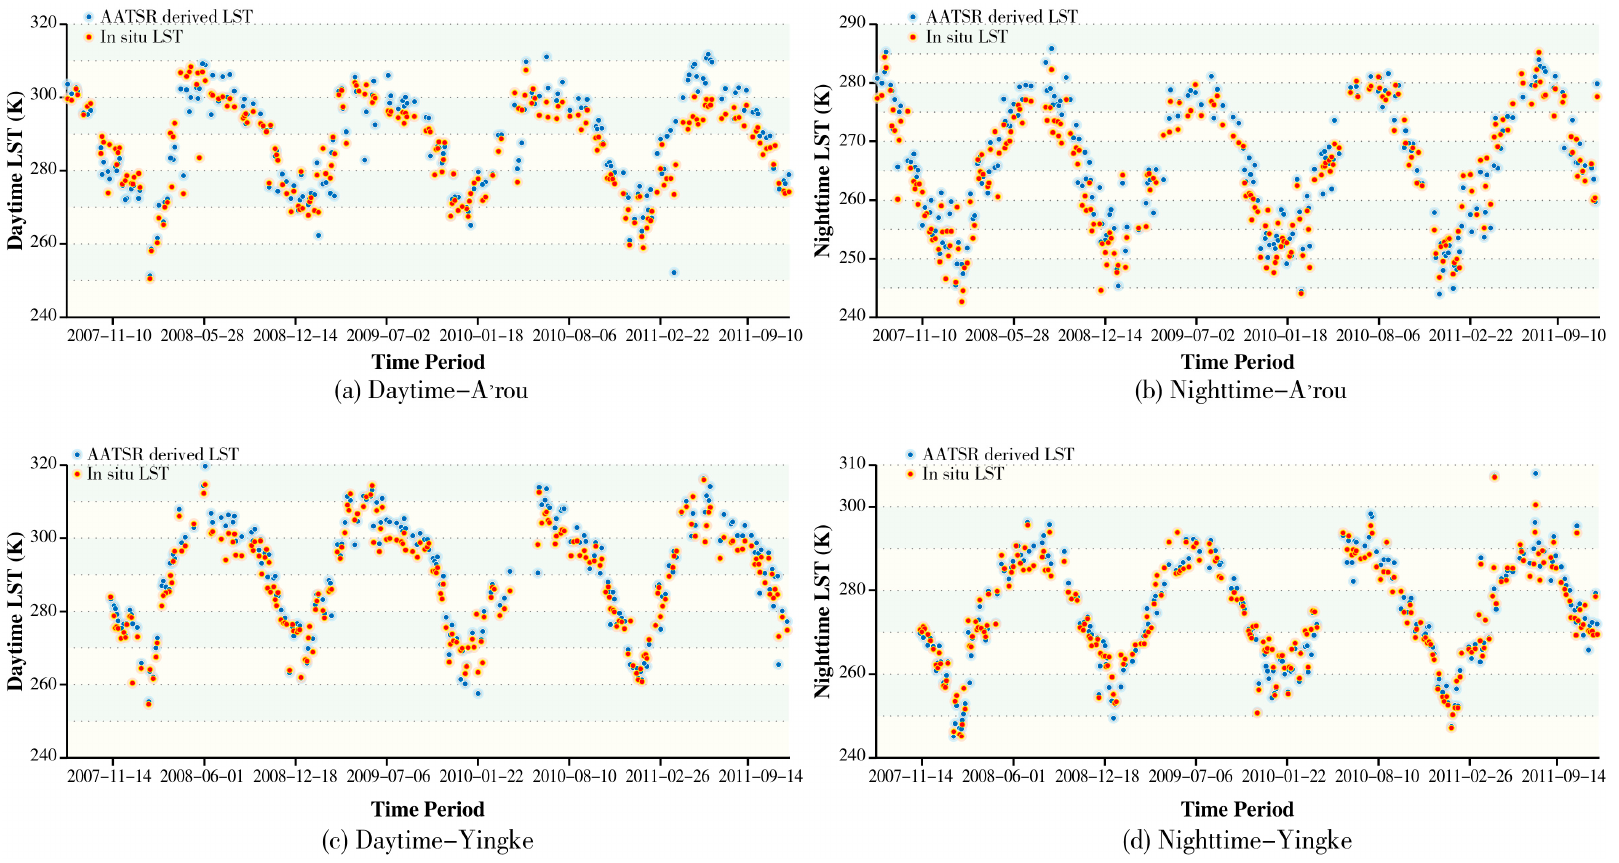
Figure 3. Annual phase comparison results between AATSR-derived LST and in situ LST at A’rou and Yingke site for 2007–2011: ( a ) daytime comparison at A’rou site; ( b ) nighttime comparison at A’rou site; ( c ) daytime comparison at Yingke site; ( d ) nighttime comparison at Yingke site.